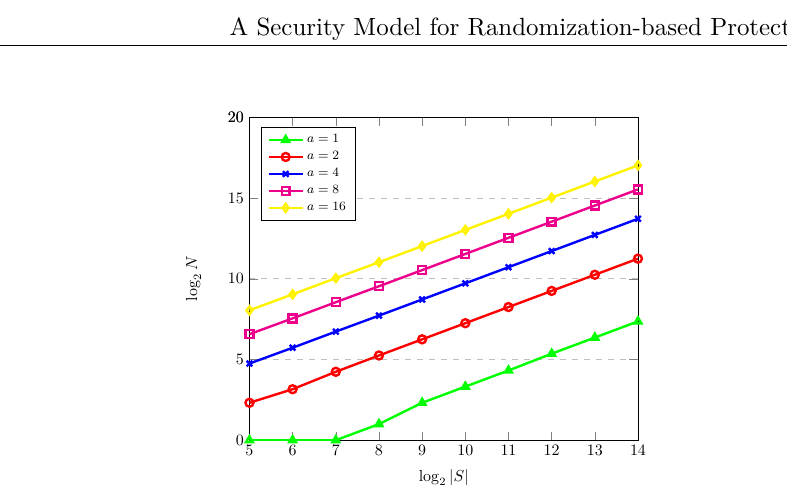
Figure 5: Rekeying periods N so that C is N -access secure with advantage at most 0 . 01, where | S | denotes the number of cache sets and a the